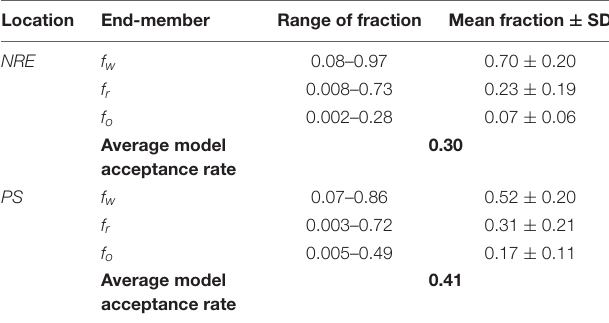
TABLE 4 | Results of the best model output of fractional contributions from the BMC mixing model in the NRE and